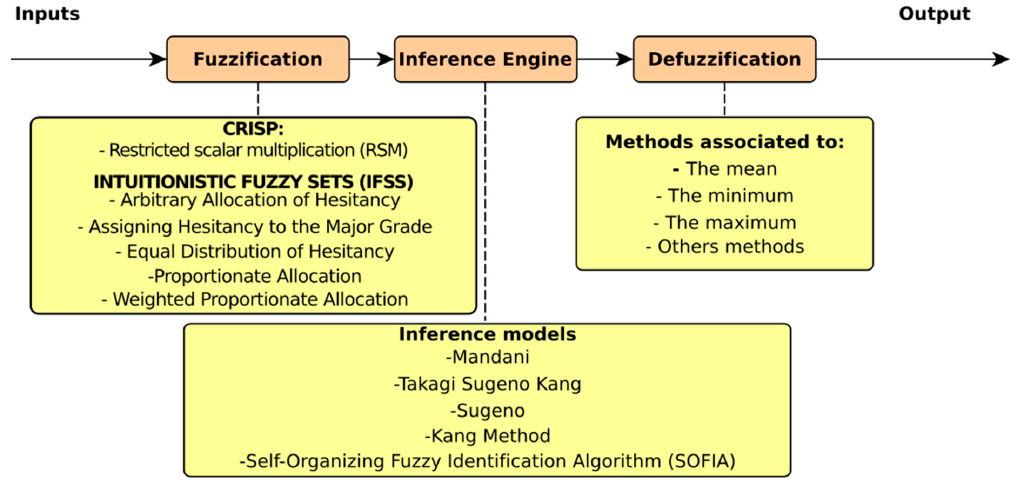
Figure 15. Basic scheme of a fuzzy inference system and models applied in each stage. Source [11,189–191], own elaboration.